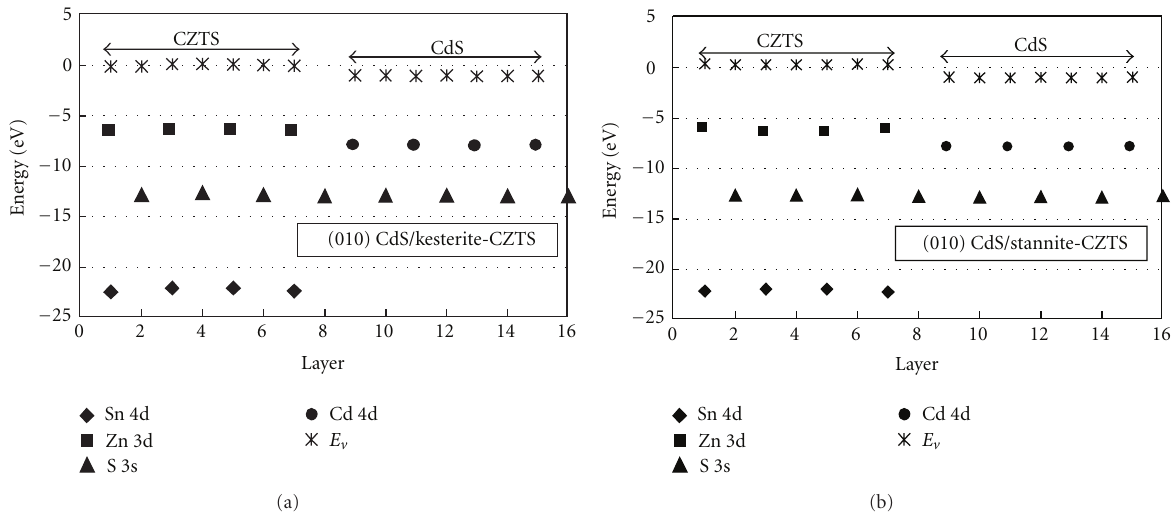
Figure 4: Calculated reference core levels and VBM for the respective layer in the (010)-oriented CdS/CZTS supercell. (a) CdS/kesterite- CZTS. (b) CdS/stannite-CZTS.